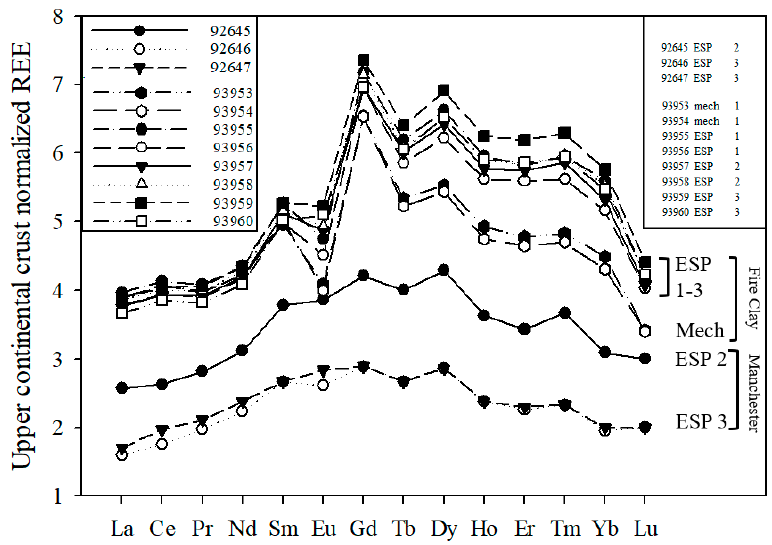
Figure 4. Upper continental crust-normalized REE distribution after Taylor and McLennan [27] for the Fire Clay- and Manchester-coal-derived fly ashes.